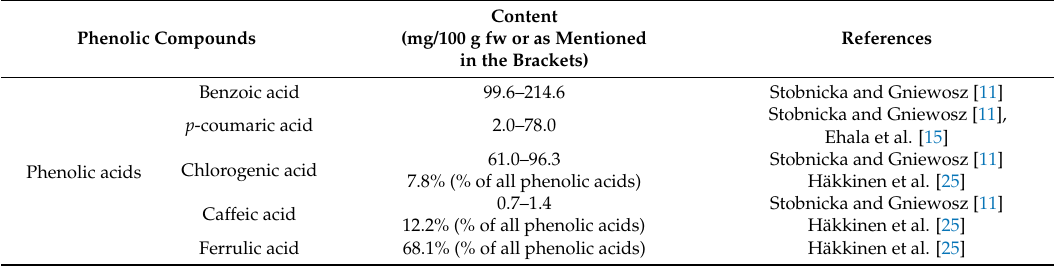
Table 1. The overview of major phenolic compounds in European cranberry. Phenolic